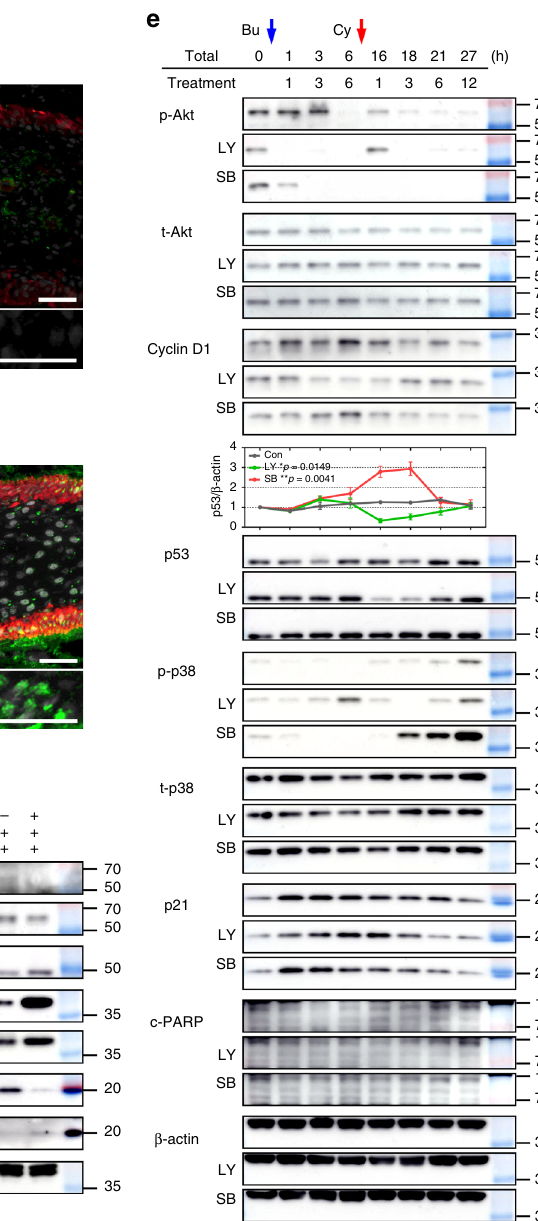
Fig. 7 Roles of PI3K/Akt and p53/p38 in phase conversion after Bu/Cy treatment. a Representative images of phosphorylated Akt + cells among K15 + HFSCs in the bulge. b Representative images of phosphorylated p38 + cells among K15 + HFSCs in the bulge (immuno fl uorescence; scale bar = 50 μ m). c Protein analysis after Bu and/or Cy treatment with PI3K inhibitor (20 µ M; LY294002) comparing the concentrations of phosphorylated PI3K, phosphorylated and total Akt, cyclin D1, p53, and phosphorylated and total p38, with β -actin as a loading control ( n = 4 biological samples, Supplementary Fig. 8a). d Protein analysis after Bu and/or Cy treatment with p38 inhibitor (10 – 20 µ M; SB202190 or SB203580) comparing the concentrations of phosphorylated and total Akt, p53, phosphorylated and total p38, p21, and cleaved caspase-3, with β -actin as a loading control ( n = 4 biological samples, Supplementary Fig. 8b). e Protein analysis after sequential Bu/Cy treatment with PI3K or p38 inhibitor showing the temporal changes of phosphorylated and total Akt, cyclin D1, p53, phosphorylated and total p38, p21, and cleaved PARP, with β -actin as a loading control. Temporal quanti fi cation plots of the concentrations of p53 per β -actin ( n = 4 biological samples, Supplementary Fig. 9; Western blotting). Bu busulfan, Cy cyclophosphamide, Bu/Cy busulfan followed by cyclophosphamide, LY LY294002; SB SB202190 or SB203580, c-caspase-3 cleaved caspase-3, c-PARP cleaved PARP. Data are mean ± SEM. Source data are provided as a Source Data fi le. * p < 0.05 (vs. Con); ** p < 0.01 (vs. Con, two-way analysis of variance with Dunnett ’ s